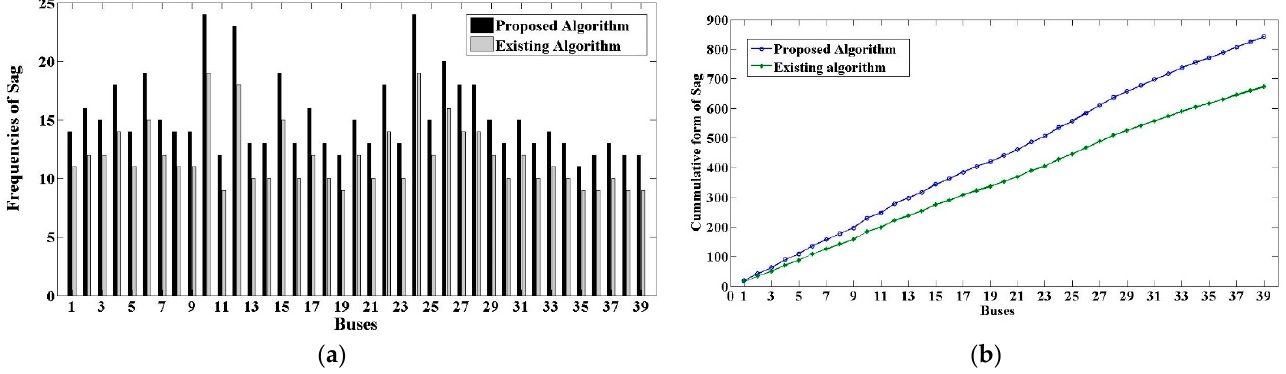
Figure 7. Comparison of proposed and existing algorithm [3]; ( a ) Sags associated to SLGF; ( b ) Cumulative number of sags.